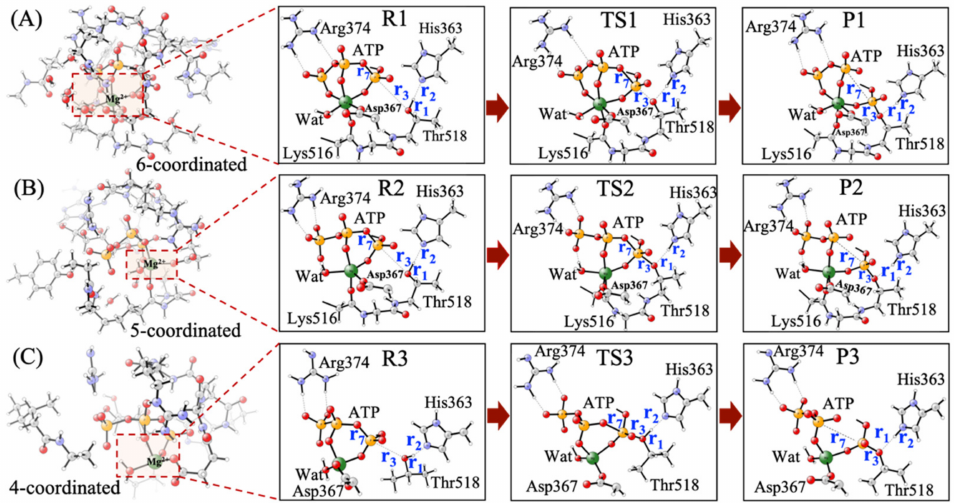
Figure 2. Reactant, TS and product of AMPylation between HYPE protein and substrate BiP protein. Three lines ( A , B and C ) are corresponding to the 6-coordinated, 5-coordinated and 4-coordinated, respectively. Some residues are not shown for clarity. Atom color code used, P (orange), Mg 2+ (green), O (red), N (blue), C (grey) and H